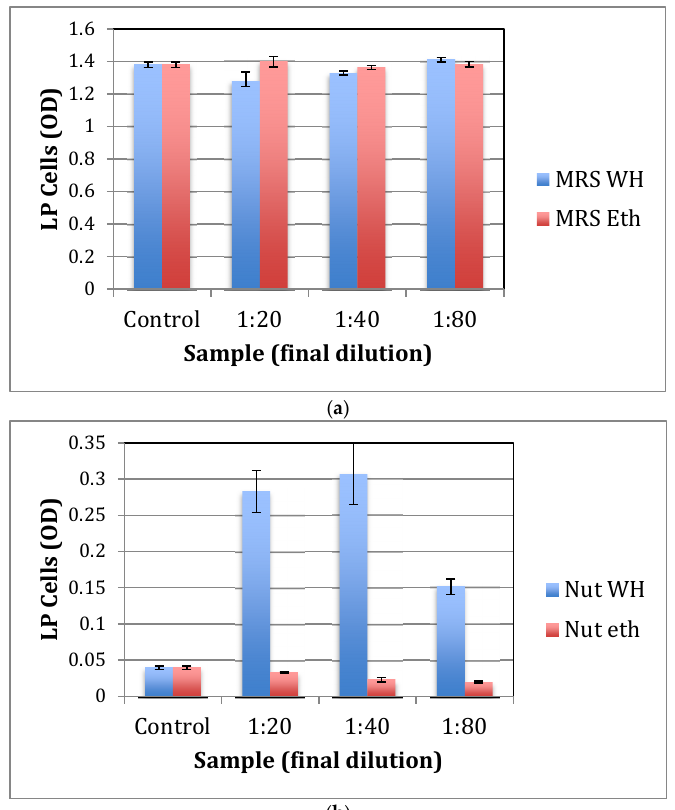
Figure 3. The effect of witch hazel on the growth of L. plantarum . ( a ) Bacteria were grown overnight in MRS both in the presence of increasing amounts of whISOBAX, ethanol (50%, starting solution) or culture broth alone (control). OD 630 was determined after 48 h. ( b ) Bacteria were grown overnight in nutrient both (Nut) in the presence of increasing amounts of whISOBAX, ethanol (50%, starting solution) or culture broth alone (control). OD 630 was determined after 48